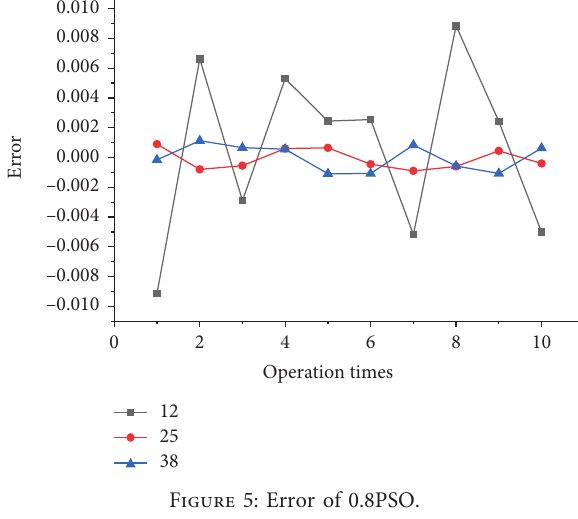
Figure 5: Error of